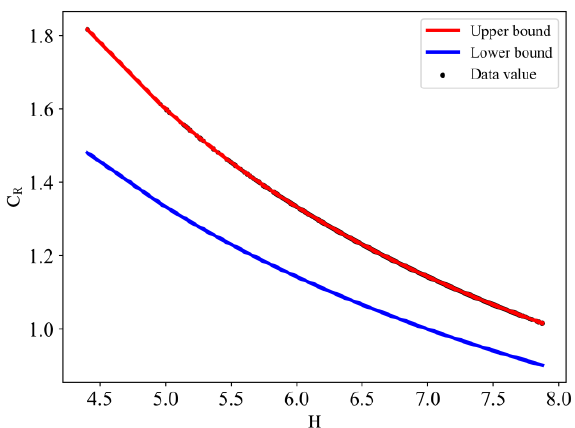
Figure 6. Theoretical bounds of Shannon’s theorem and the scatter plot of H against C R values obtained by Arithmetic coding